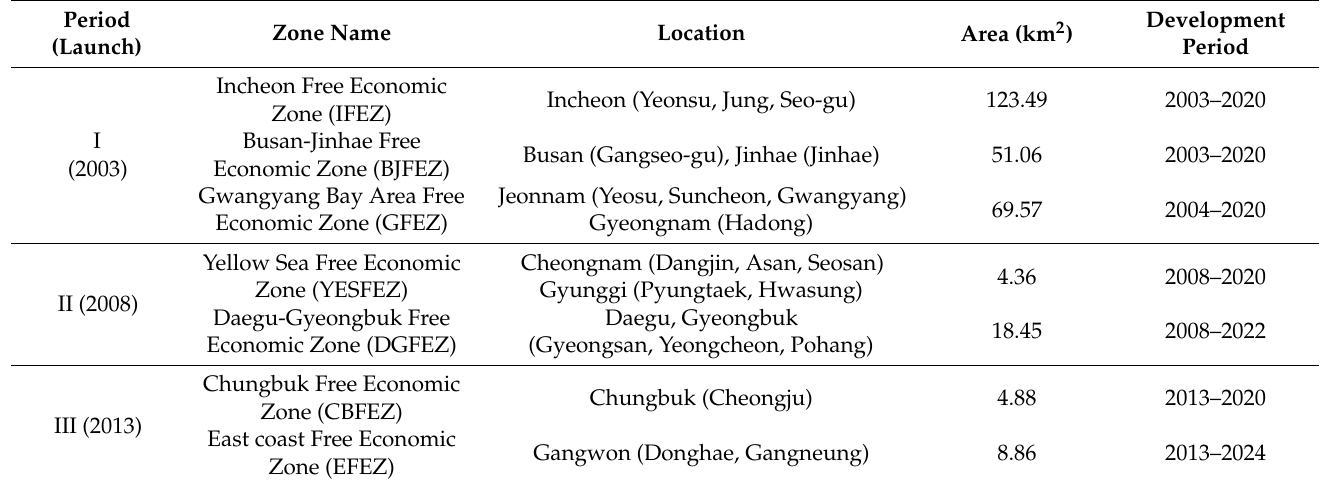
Table 1. Status of Korean Free Economic Trade